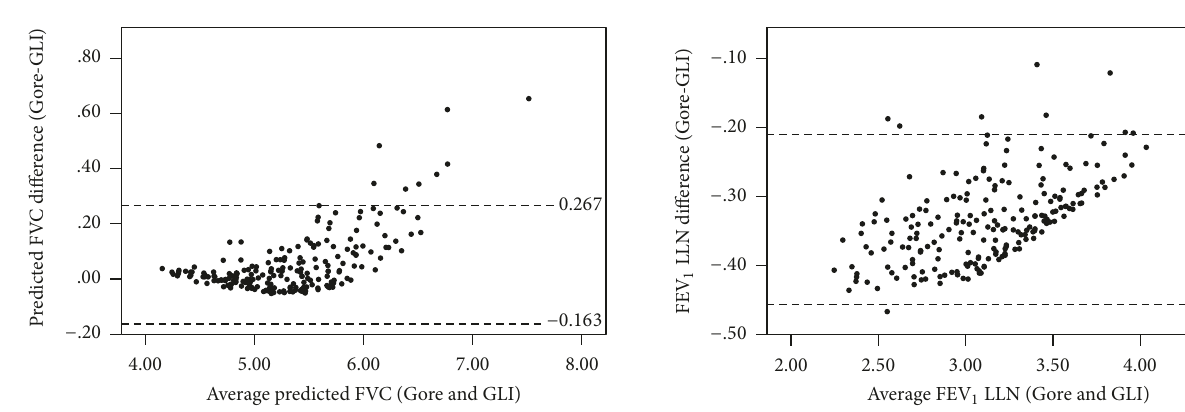
Figure 2: Differences of FEV 1 LLN for Gore compared with GLI illustrating the lower LLN for GLI, particularly for lower values ( 𝑁 = 212).